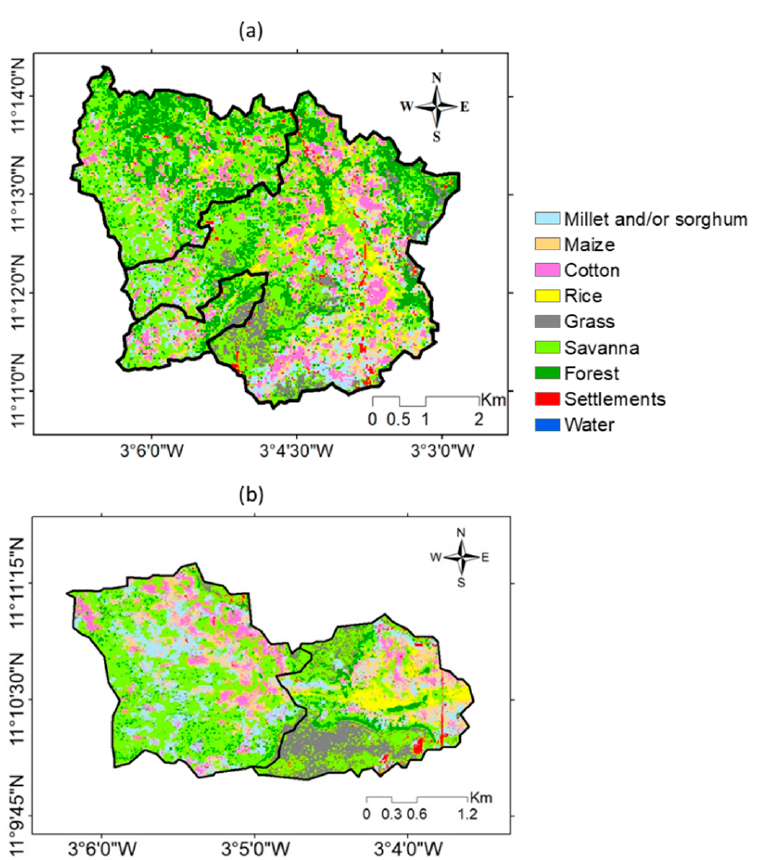
Figure 3. Land use / land cover maps of the investigated catchments. ( a ) Bankandi-Lo ffi ng, ( b ) Mebar. Figure 3. Land use/land cover maps of the investigated catchments. ( a ) Bankandi ‐ Loffing, ( b ) Mebar. (Dataset: (Dataset: [68]).